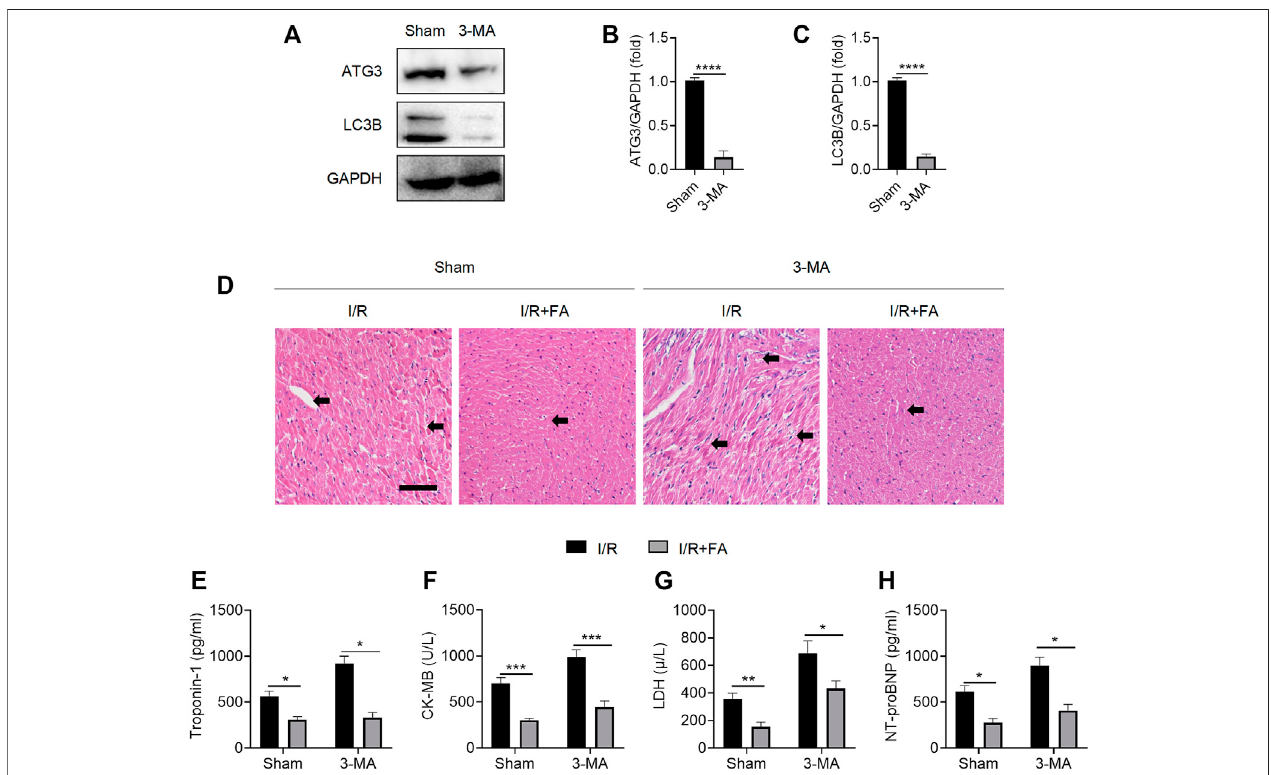
FIGURE6| FAdoesnotalleviateI/R-inducedmyocardialinjurythroughautophagy. (A – C) WesternblottingdetectionoftheexpressionofATG3andLC3Bproteins inthehearttissueofWTmicetreatedwithsalineor3-MA. (D) HEstainingresultsofhearttissuesectionsinWTmicetreatedwithsalineor3-MA. (E – H) ExpressionofCK- MB, LDH, troponin-1, and NT-proBNP in the serum of each experimental group, detected by ELISA. Data are expressed as the means ± sd from three independent experiments or are representative of three independent experiments. * p < 0.05, ** p < 0.01, *** p < 0.001, and **** p < 0.0001.